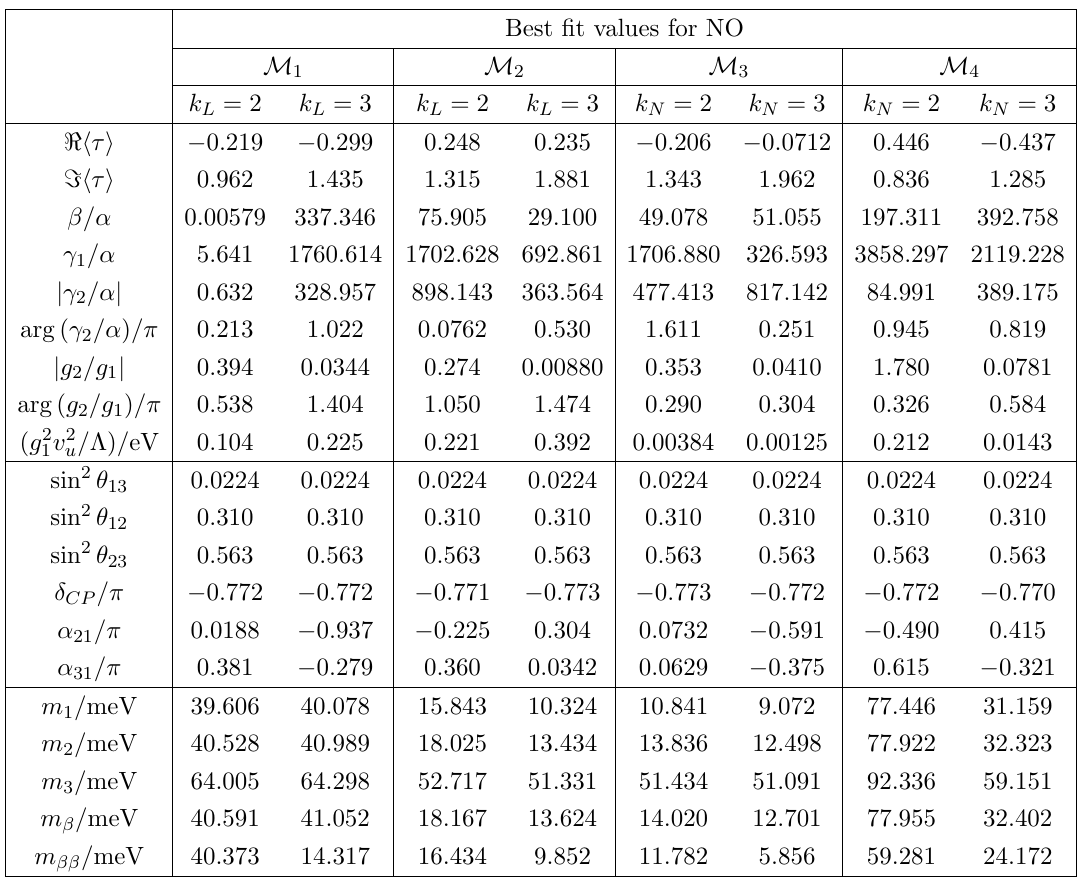
Table 5 . The predictions for lepton mixing parameters and neutrino masses for the four models for